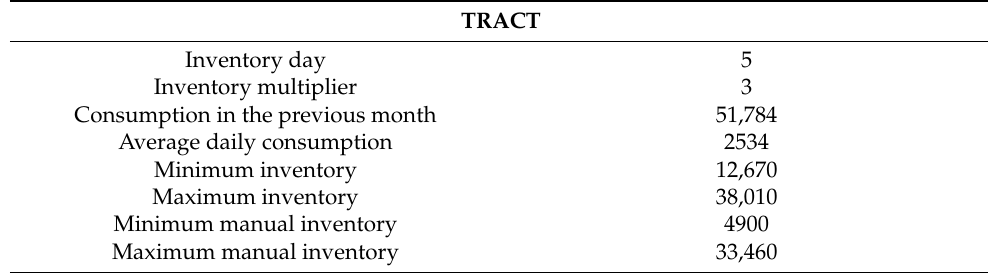
Table 1. Basic information of drug inventory